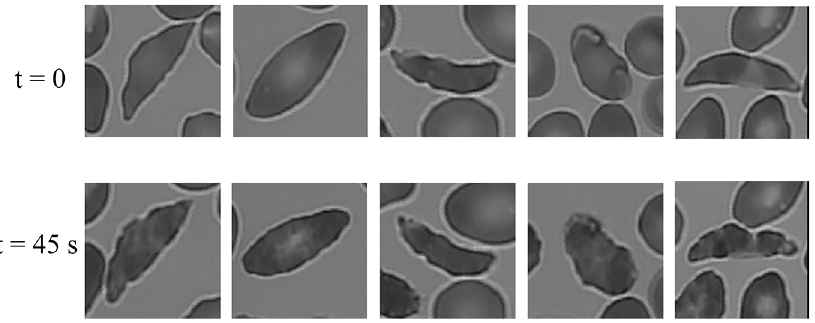
Fig 18. First row: (t = 0) Irreversibly sickled cells (ISCs) under normoxiai.e., Oxy state [ O 2 ]: 20%; Initiation of deoxygenation. Second row: (t = 45s) Deoxygenated ISCs i.e., DeOxy state [ O 2 ]: 2%; (see S4 Appendix methods on Oxy/DeOxy states).